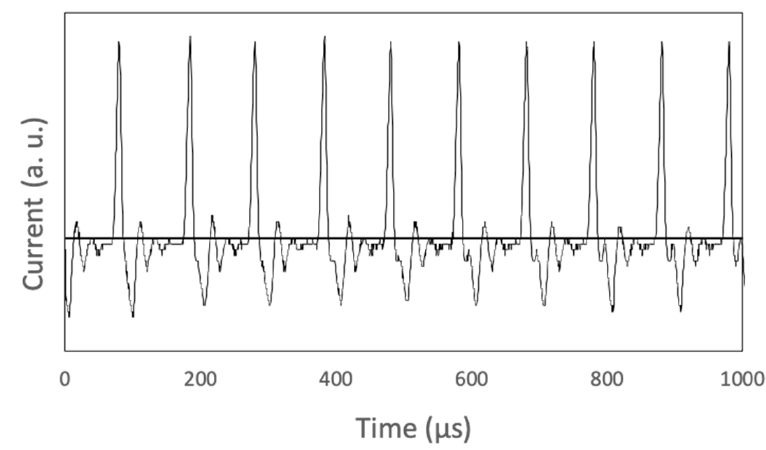
Figure 2. Waveform of output current.